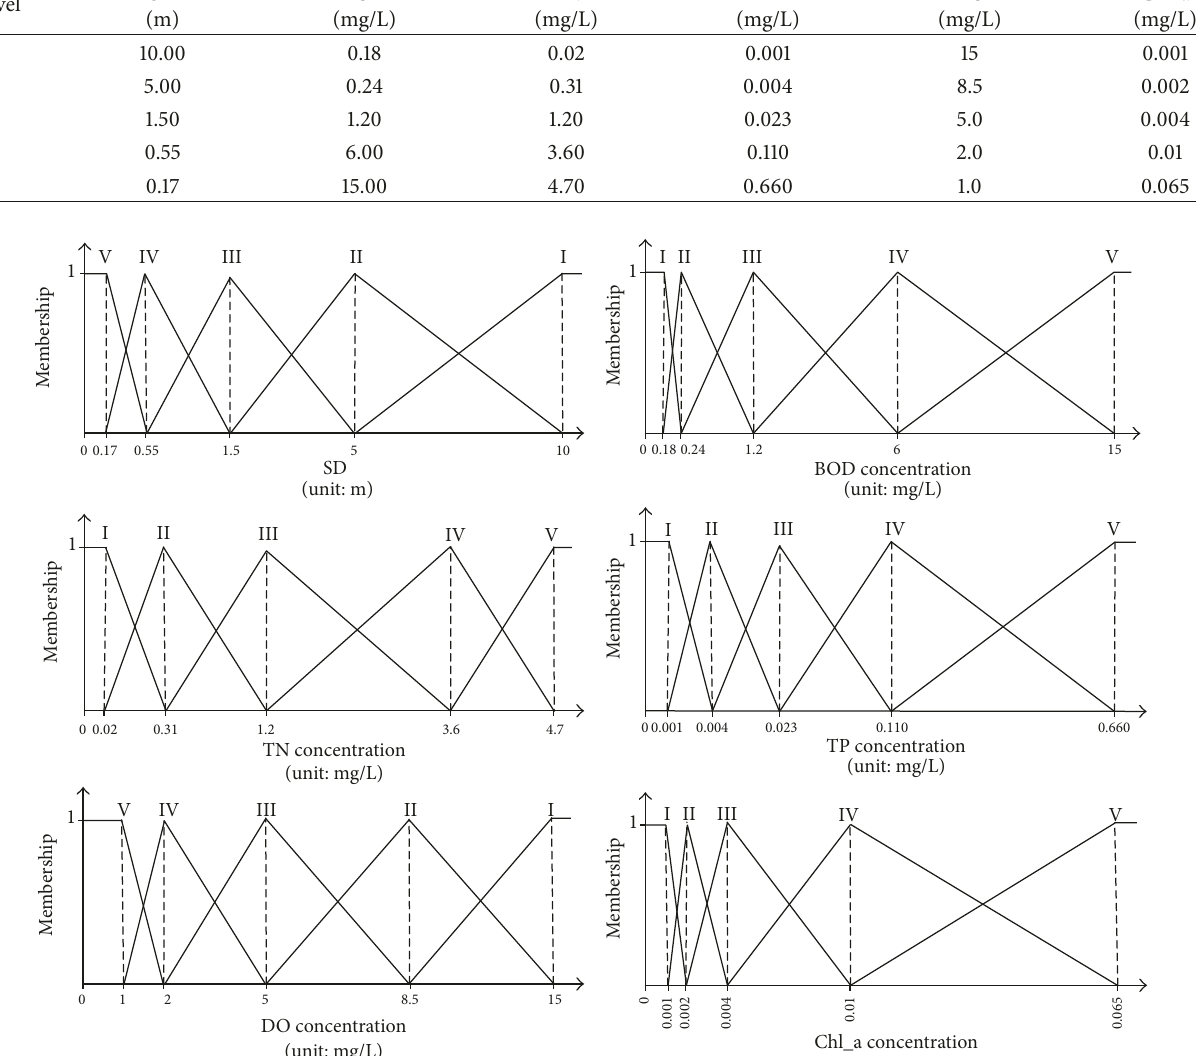
Table 3: Standard values of water quality indexes for lakes and reservoirs.